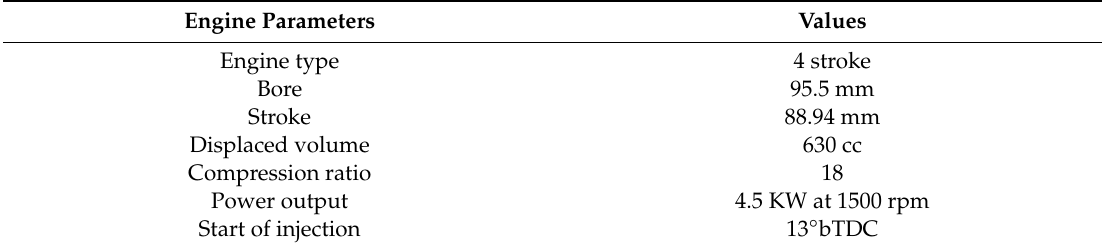
Table 6. Details of engine used for